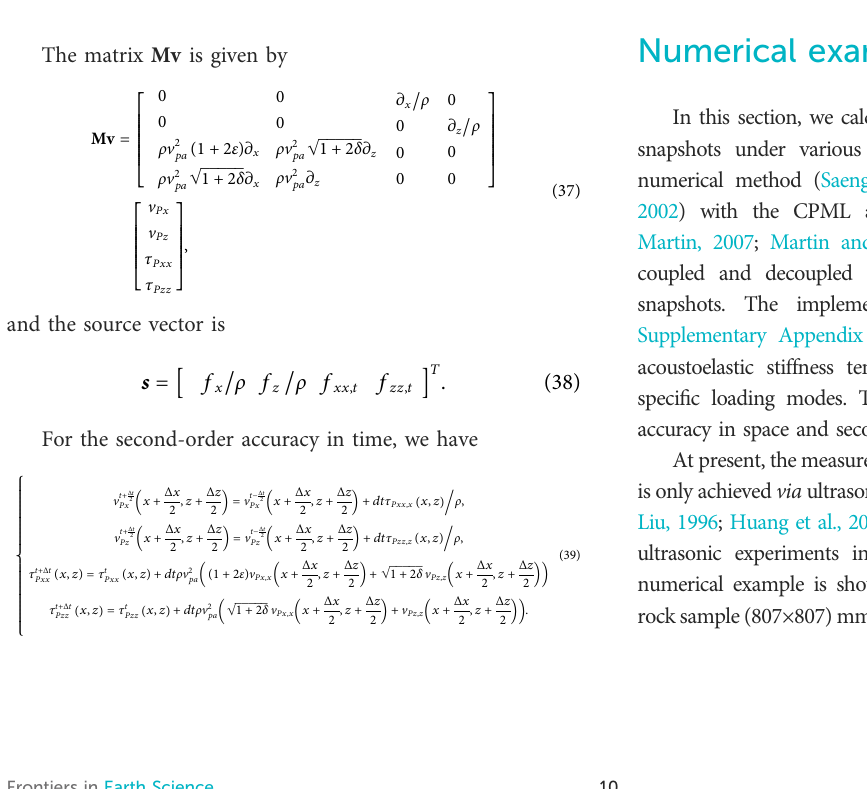
Frontiers in Earth